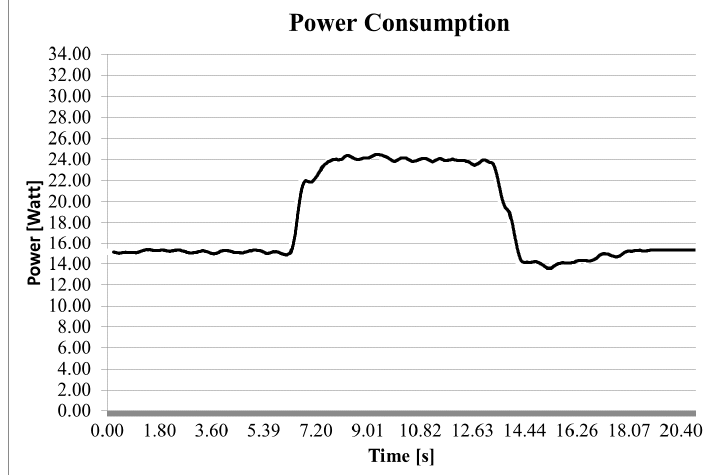
Figure 10. Measured power consumption during the test in Figure 8.